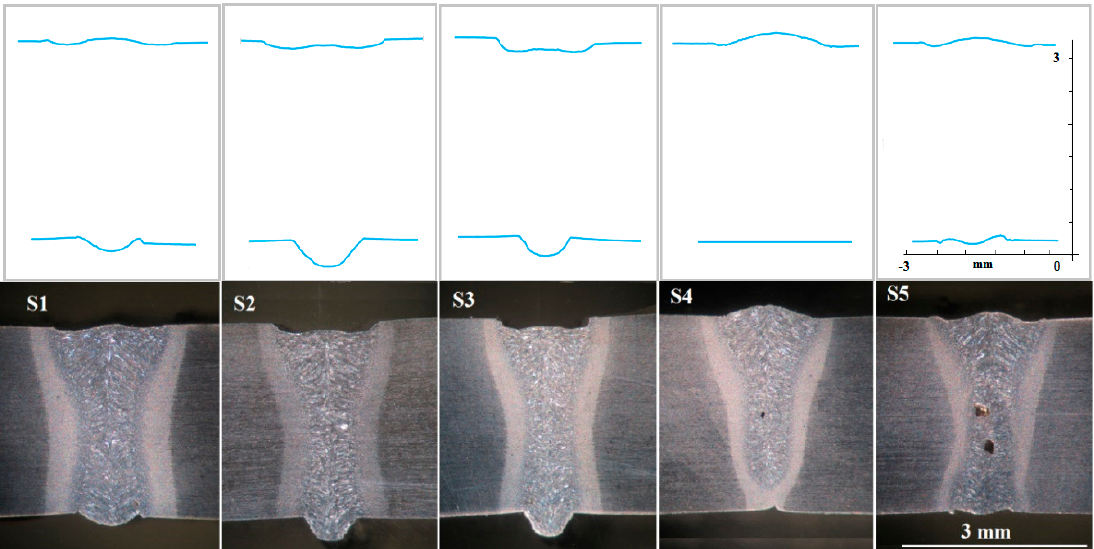
Figure 2. Appearance of the weld beads for welded series: profiles ( above ); macrographs ( below ). Figure 3 proposes the geometric parameters that define two idealized profiles: t-profile and b-profile. Due to symmetry, only half of the profiles are shown. The combination of these two idealized profiles allows the modelling of any weld bead profile of the welded series. Therefore, the top and bottom profiles of the S1, S2 and S3 series can be reproduced by the idealized profiles t-profile and b-profile, respectively, for the S5 series contrary to the previous ones; and for the S4 series, only the top profile can be modeled with the b-profile.